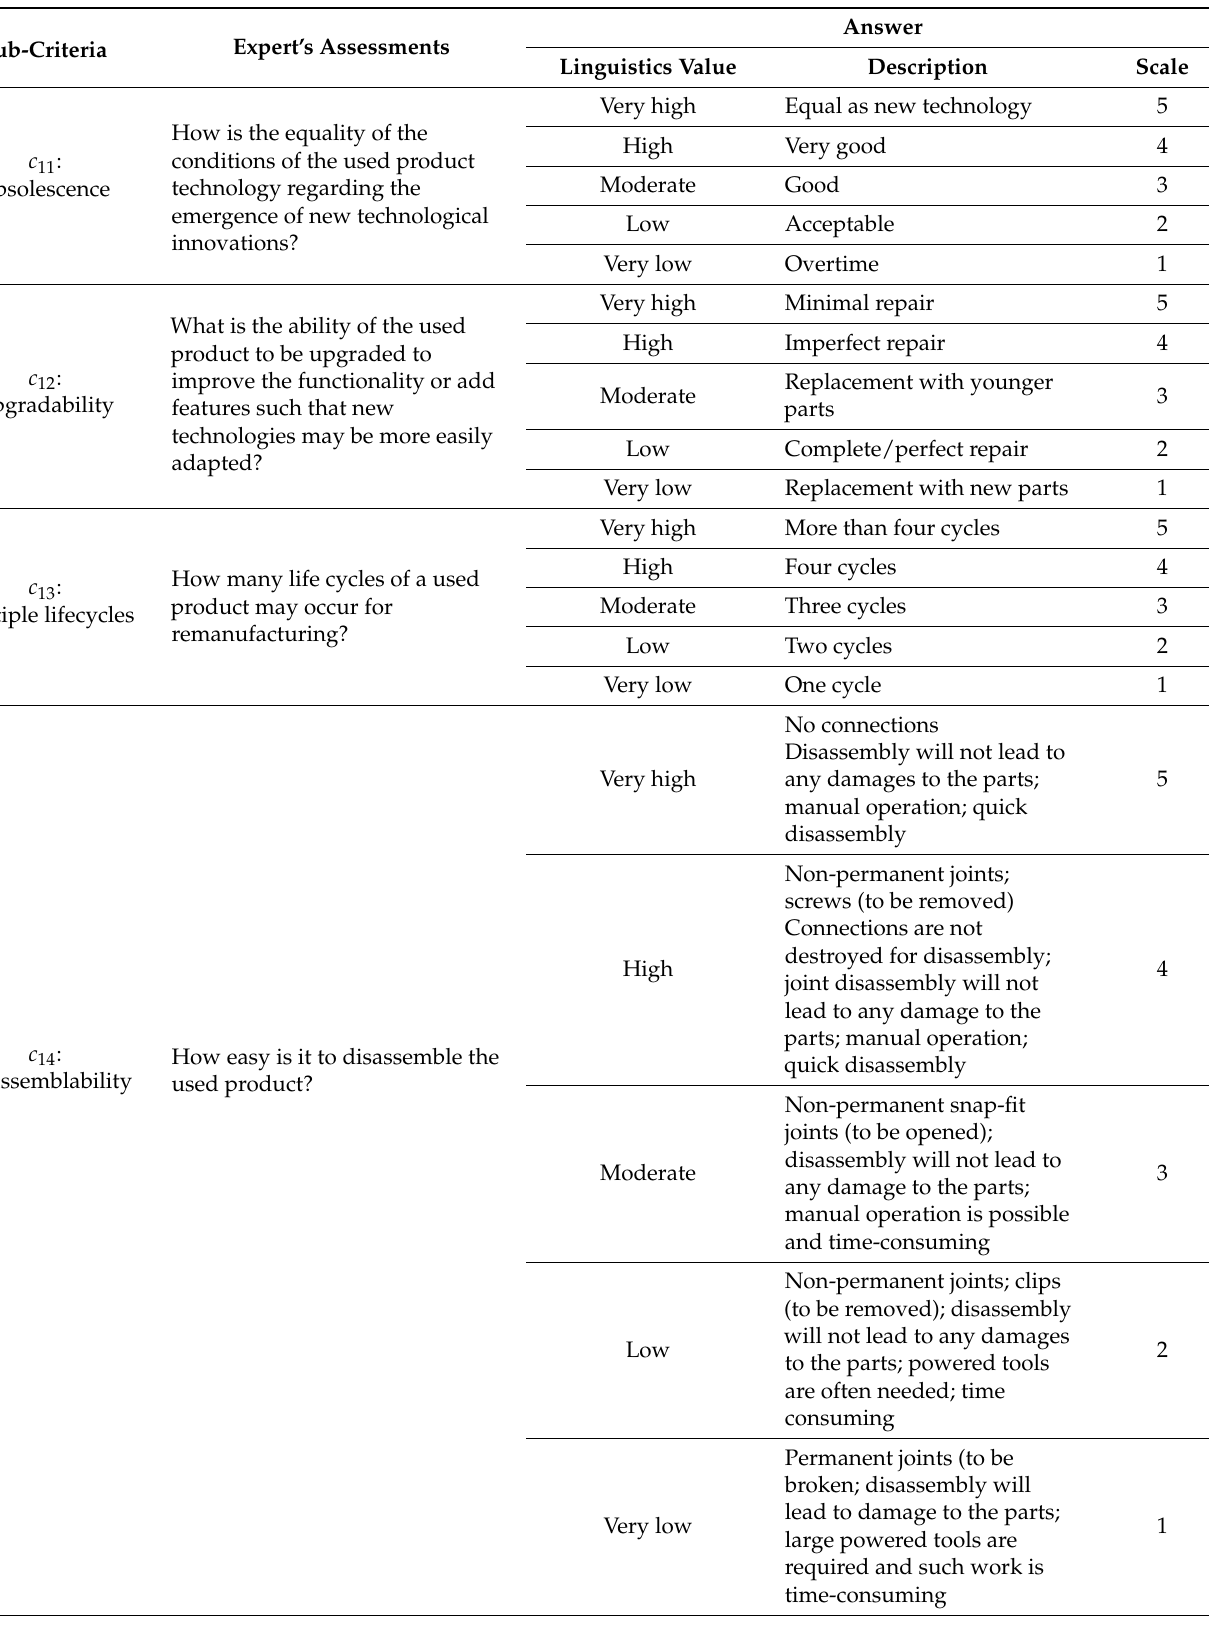
Table A2. Assessment